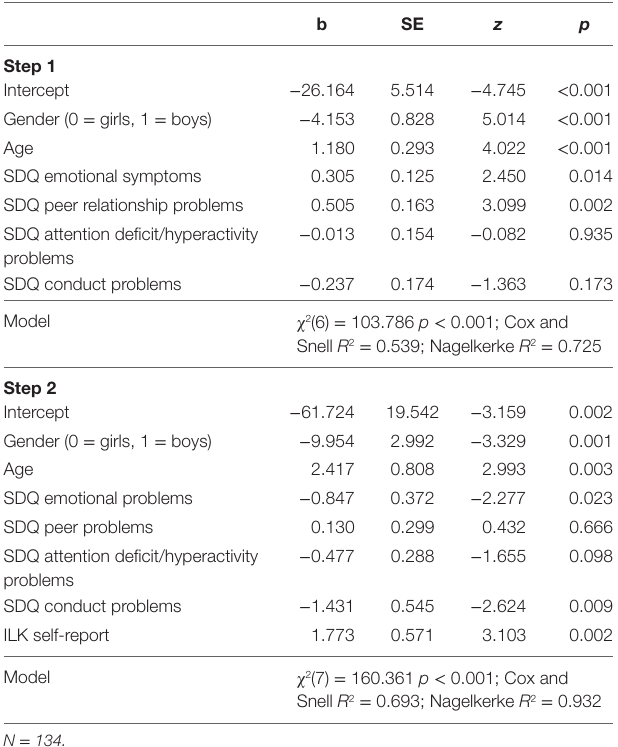
TaBle 4 | The logistic model with level of suicidal risk according to M.I.N.I. Kid (0 = no/low, 1 = medium/high) as dependent.